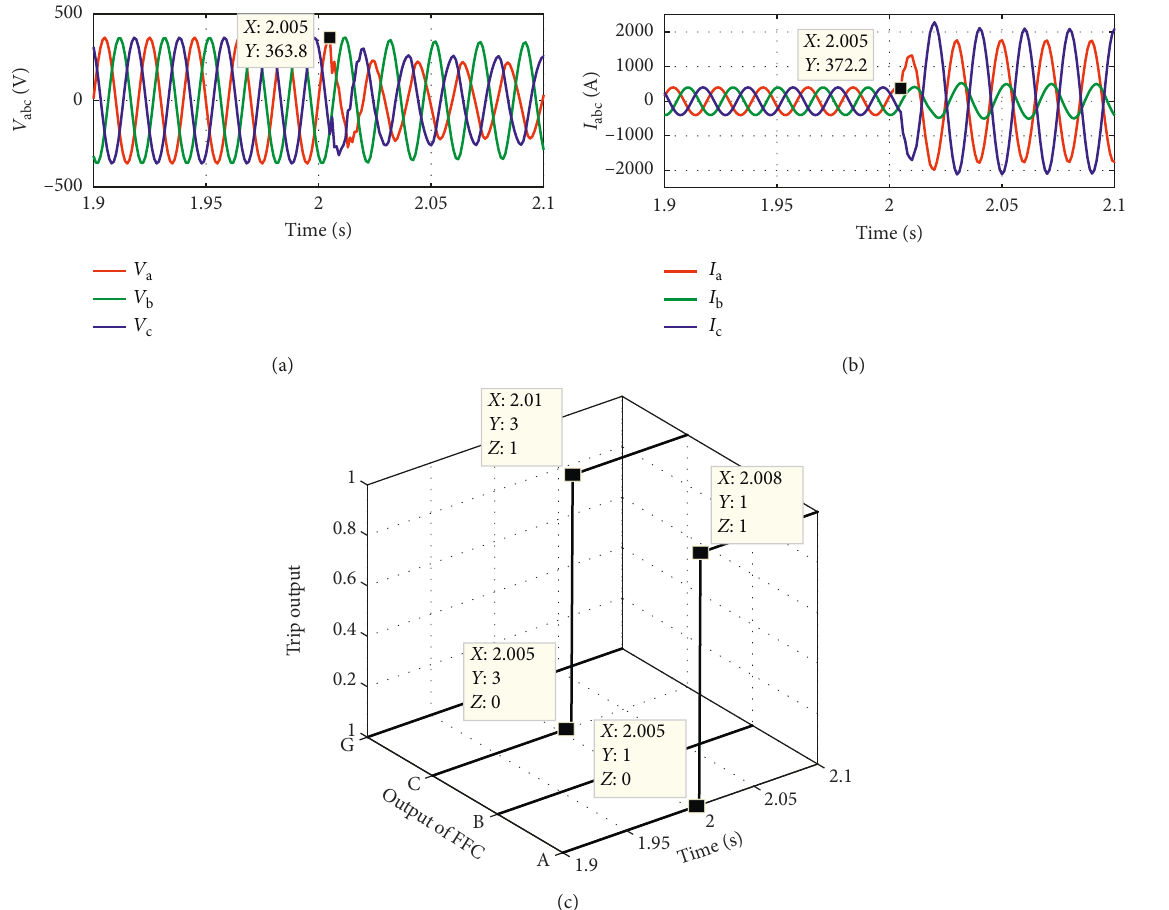
Figure 13: Performance during CA fault at 160km, FIA � 90 ° , FR � 0.001 Ω , and % Xc � 40%: (a) 3-phase voltage waveform; (b) 3-phase current waveform; (c) output of